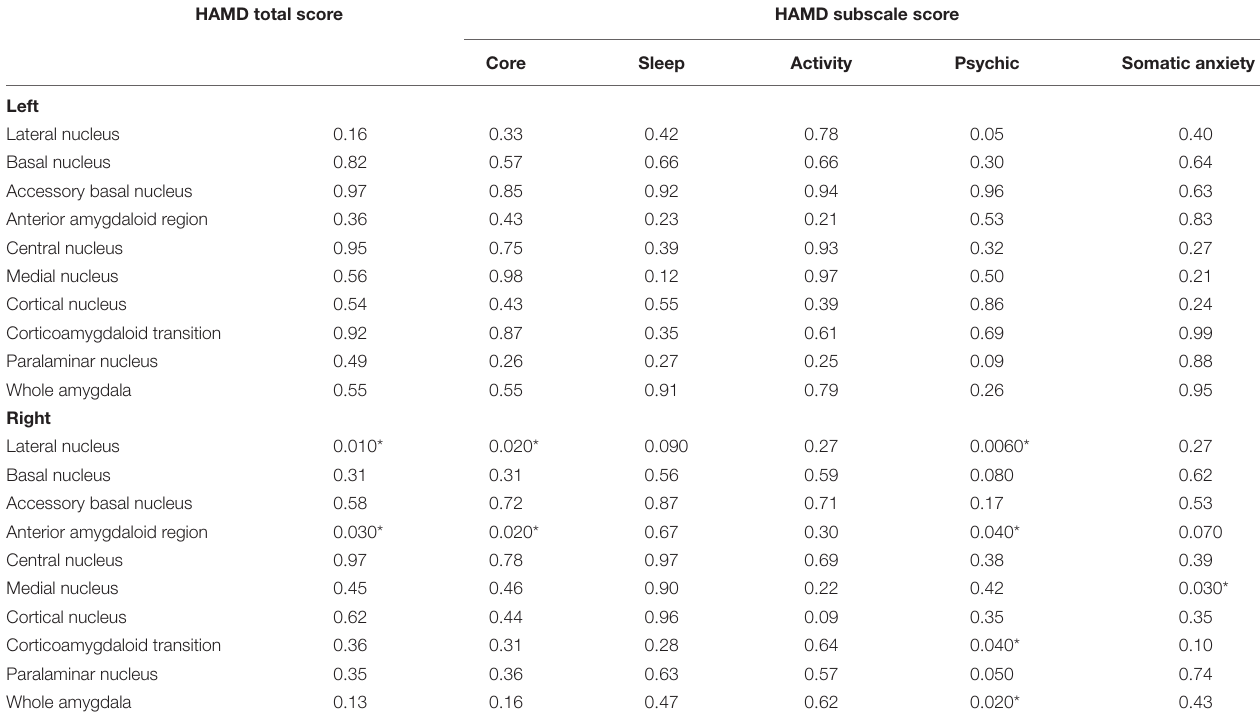
TABLE 3A | The HAMD scores and amygdala subregions.